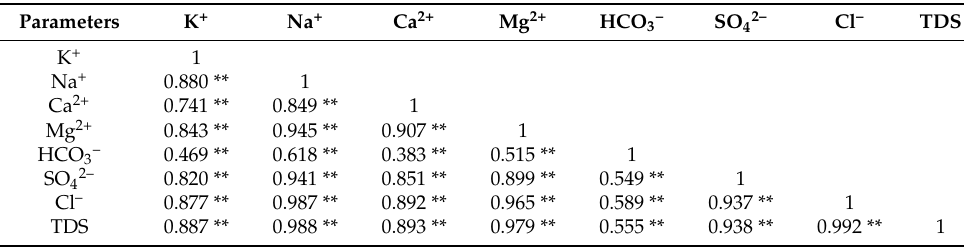
Table 1. Correlation coefficient matrix of the hydrochemical parameters.